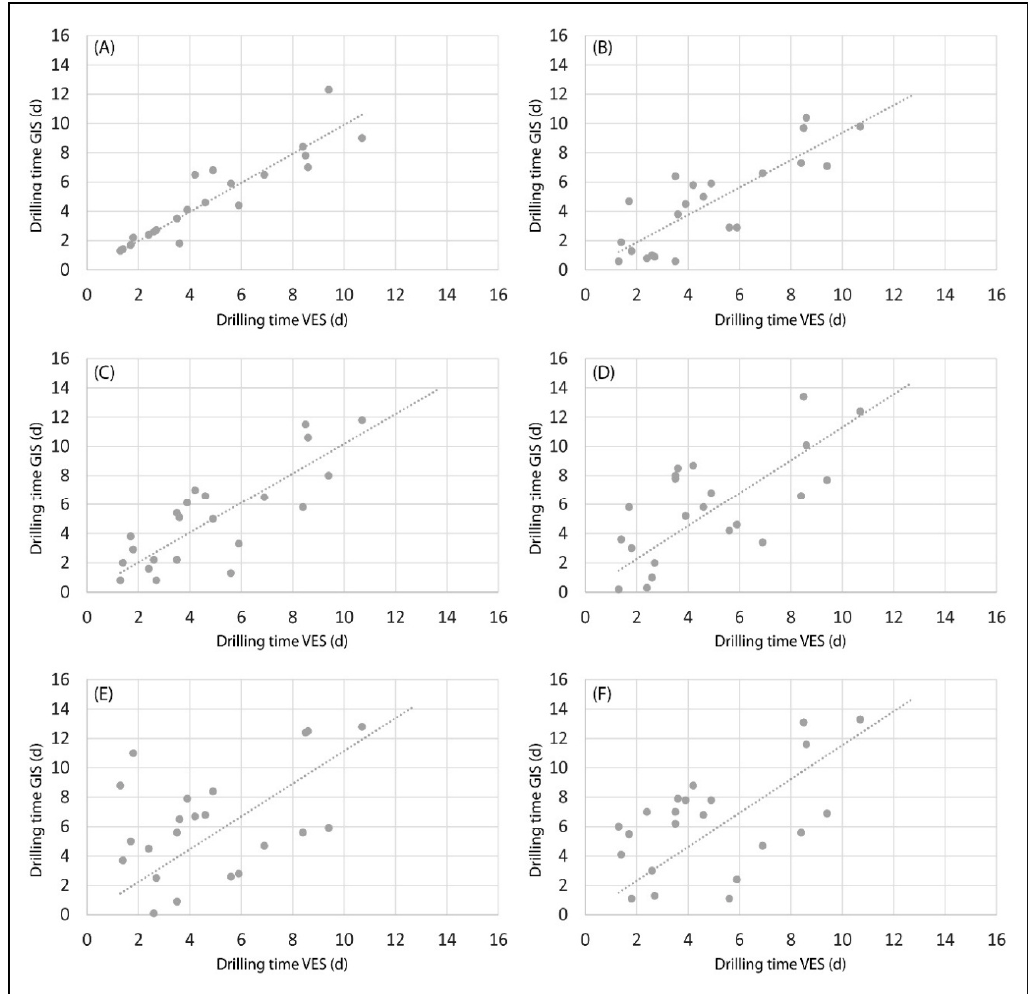
Figure 14. Drilling time estimates obtained by two independent methods (vertical electrical sounding and the GIS database). Times are referred to three-inch diameter boreholes. ( A ) Ordinary kriging; ( B ) minimum curvature; ( C ) polynomial regression; ( D ) modified Shepard’s method; ( E ) inverse distance to power; ( F ) radial basis function. Table 5. Descriptive statistics for the correlation between drilling time as obtained by means of vertical electrical sounding and through the GIS database (OK: ordinary kriging; MC: minimum curvature; RBF: radial basis function; MSM: modified Shepard’s method; IDP: inverse distance to power; PR: polynomial